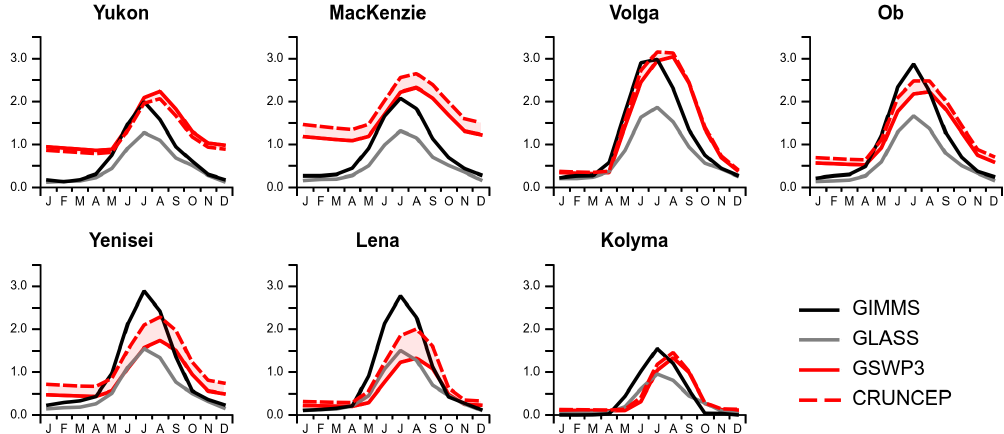
Figure 13. Monthly mean seasonal LAI (–) simulated with the two forcings compared to GIMMS and GLASS products over the seven basins (see Fig. 2b), averaged over the period